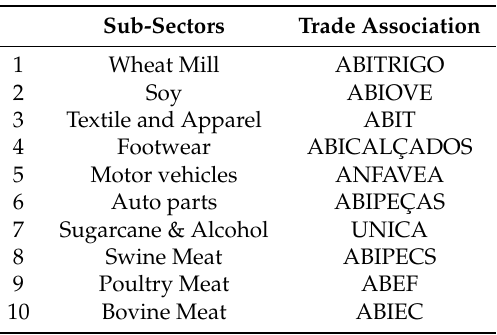
Table 1. Selected